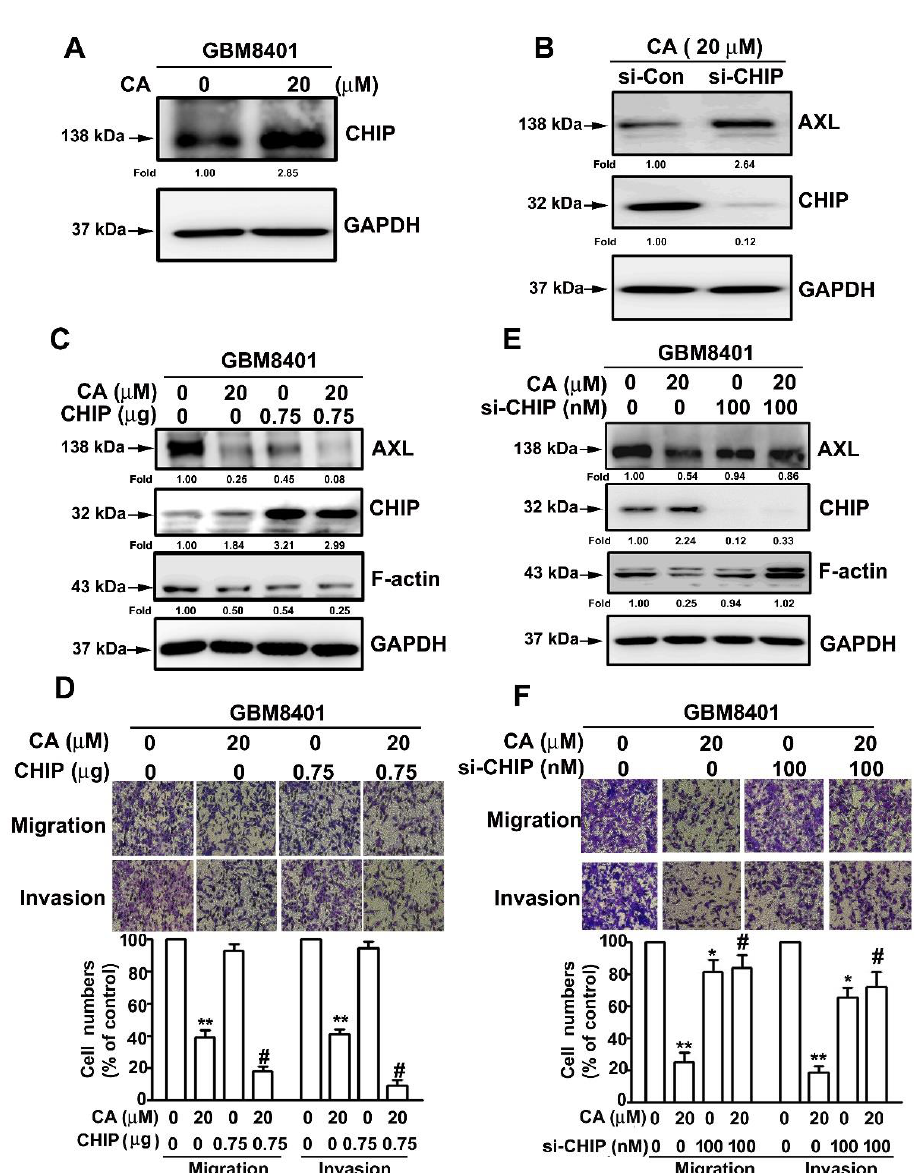
Figure 5. CHIP involvement in CA-inhibited migration and invasion of GBM8401 cells. ( A , B ) Cells were treated with CA (20 μ M) ( A ) or siRNA against CHIP (si-CHIP) ( B ) and then lysed for CHIP and AXL immunodetection by Western blotting. ( C , D ) Cells were treated with CA (20 μ M), CHIP (0.75 µ g) or CA and CHIP, and then lysed for AXL, CHIP and F-actin immunodetection by Western blotting ( C ) or subjected to migration and invasion assay ( D ). ( E , F ) Cells were treated with CA (20 µ M), si-CHIP (100 nM) or CA and si-CHIP, and then lysed for AXL, CHIP and F-actin immunodetection by Western blotting ( E ) or subjected to migration and invasion assay ( F ) Chemiluminescence signal was semi-quantitated by densitometric analysis, and GAPDH was used as an internal control. * and ** p < 0.05 and 0.01, respectively, compared with the control (DMSO-treated cells). # p < 0.05 compared with CA alone. Images were acquired by light microscopy at 200× magnification.